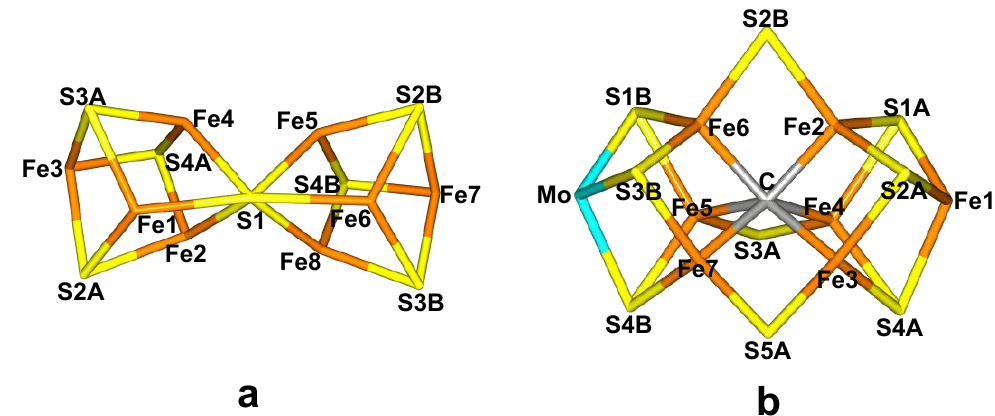
Figure 1. The cores of ( a ) the P-cluster (P N state) and ( b ) the FeMo cluster (E 0 state) with atom names indicated.